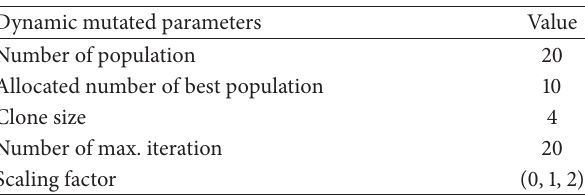
Table 1: Parameters of DM-AIS.